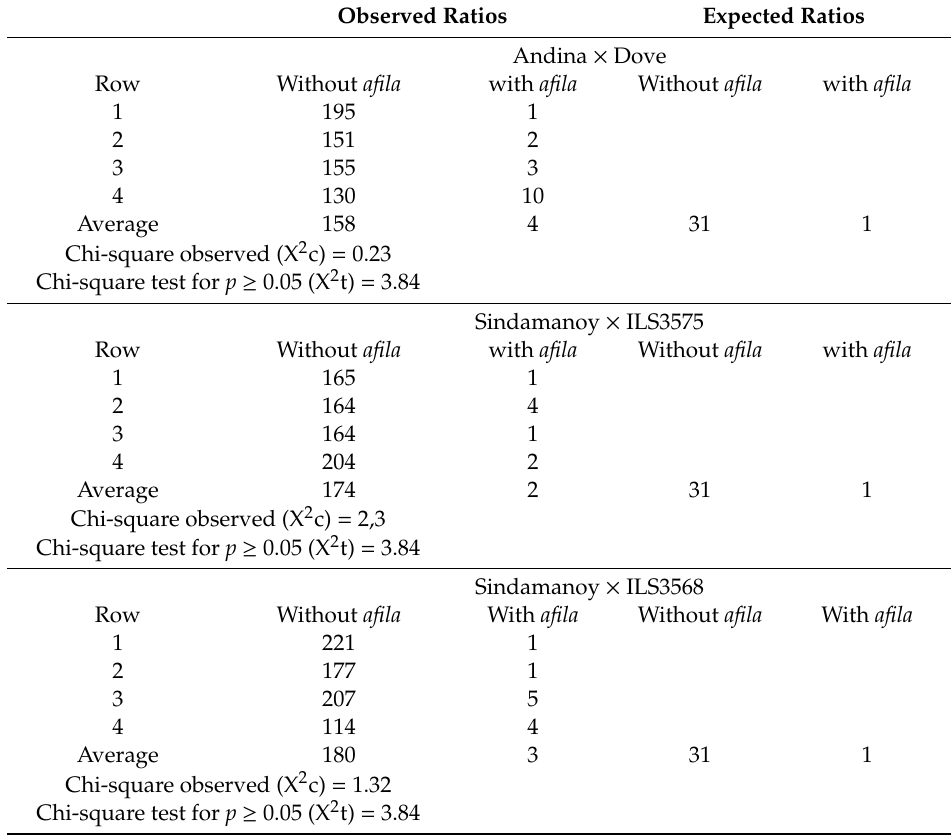
Table 3. Observed and expected segregation ratios and chi-square tests for numbers of plants with and without the expression of the homozygous recessive afila gene in the BC 3 F 2 populations from the backcrosses made with the abbreviated selection method for three climbing × bush garden pea crosses. Observed Ratios Expected Ratios Andina × Dove Without afila with afila Without afila with